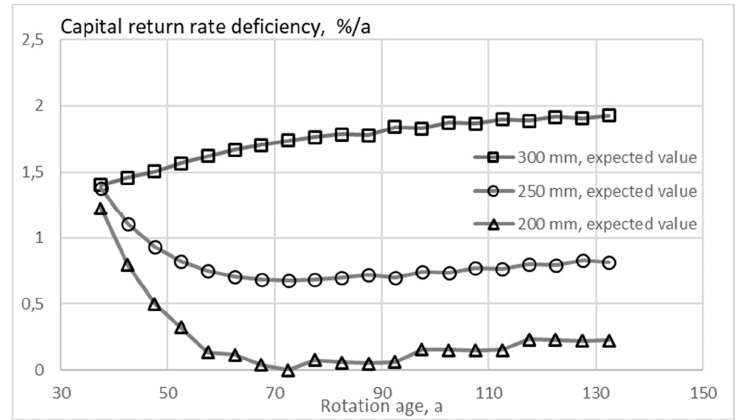
Figure 5. Capital return rate deficiency in percentage/year, for different rotation ages and three different cutting diameter limits (200 mm, 250 mm, and 300 mm).